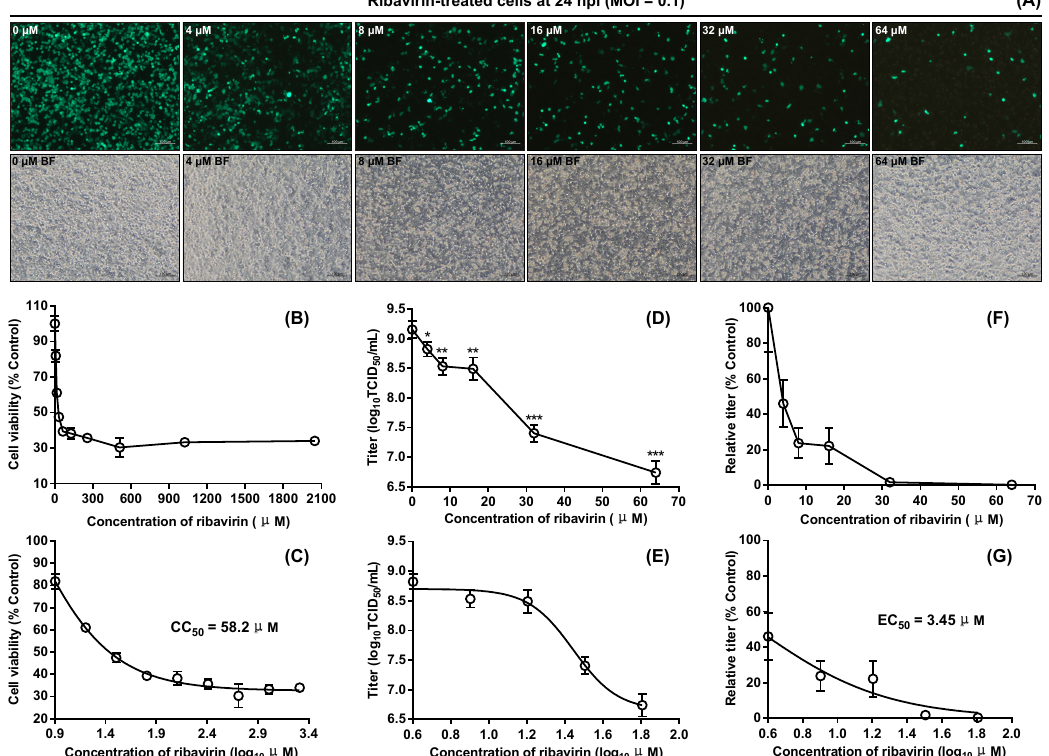
Figure 5. Anti-rSVA-eGFP assay of ribavirin in vitro. Cell monolayers with treatment of ribavirin at di ff erent concentrations (0, 4, 8, 16, 32 and 64 µ M) at 24 hpi ( A ). Each cell monolayer is observed in a randomly selected field-of-view of fluorescent microscope. Relative viability of BSR cells at 24 h after ribavirin treatment at di ff erent concentrations (0, 8, 16, 32, 64, 128, 256, 512, 1024 and 2048 µ M) by MTT assay ( B ). The data represent the mean ± SD for five replicates per dilution. The CC 50 value for ribavirin, calculated by nonlinear regression fitting using the GraphPad Prism software ( C ). Variation in rSVA-eGFP titers at 24 h after ribavirin treatment at di ff erent concentrations (0, 4, 8, 16, 32 and 64 µ M) ( D ). The data represent the mean ± SD for three independent experiments. * p < 0.05, ** p < 0.01 or *** p < 0.001: comparison between the 0 µ M group and another one by two-tailed Student (cid:48) s t -test. The data in ( D ) are processed by nonlinear regression fitting using the GraphPad Prism software, and then shown in ( E ). Variation in relative titers at 24 h after ribavirin treatment at di ff erent concentrations (0, 4, 8, 16, 32 and 64 µ M) ( F ). The data represent the mean ± SD for three independent experiments. The EC 50 value for ribavirin against rSVA-eGFP, calculated by nonlinear regression fitting using the GraphPad Prism software ( G